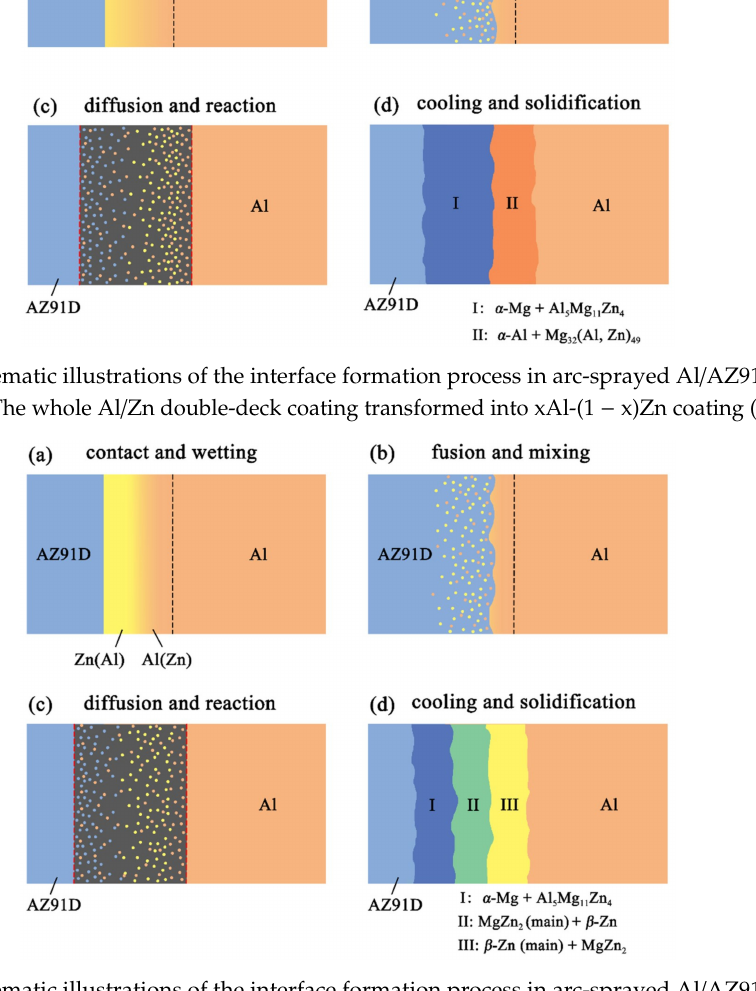
Figure 13. Schematic illustrations of the interface formation process in arc-sprayed Al / AZ91D with a Zn interlayer: Partial Al / Zn double-deck coating transformed into xAl-(1 − x)Zn coating (x >